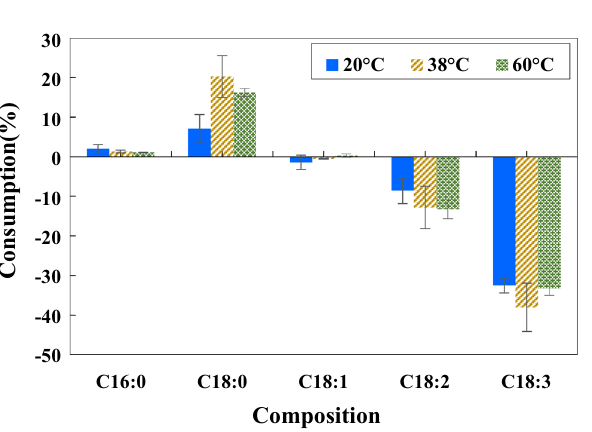
Figure 4. Effect of H 2 concentration on FAME composition changes (100 W and 1 mm gap at room temperature for 1 h).